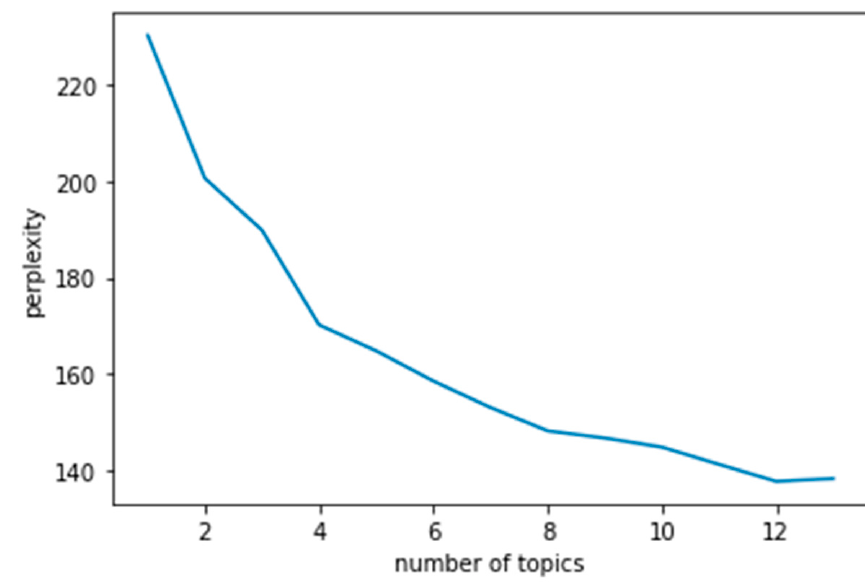
Figure 2. The trend of perplexity under different topic numbers.